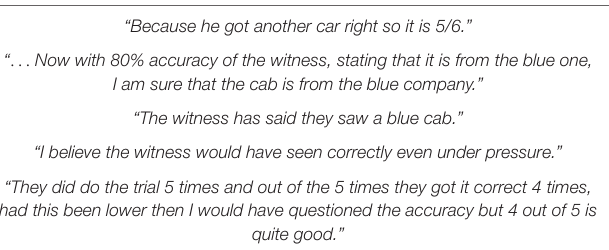
TABLE 3 | A selection of ‘Increase’ responders open-text explanations of their reasoning assigned the code ‘Witness probably correct’.